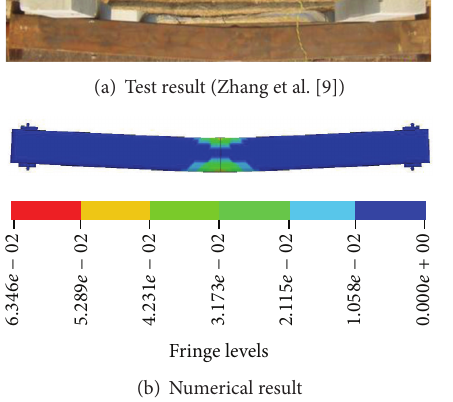
Figure 5: Comparison of the column damage mode in the test and that from numerical simulation.